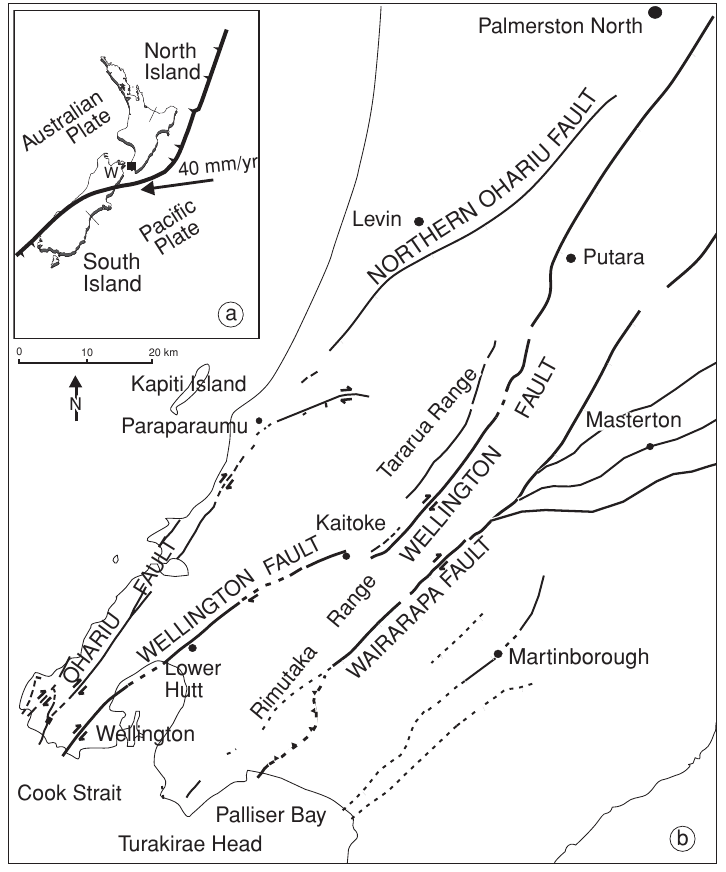
Fig. 1a,b. a) Oblique subduction of the Pacific plate beneath the Australian plate at (cid:190) 40 mm/yr at an azimuth of 265 ° at the latitude of Wellington (W). b) The main active faults in the Wellington